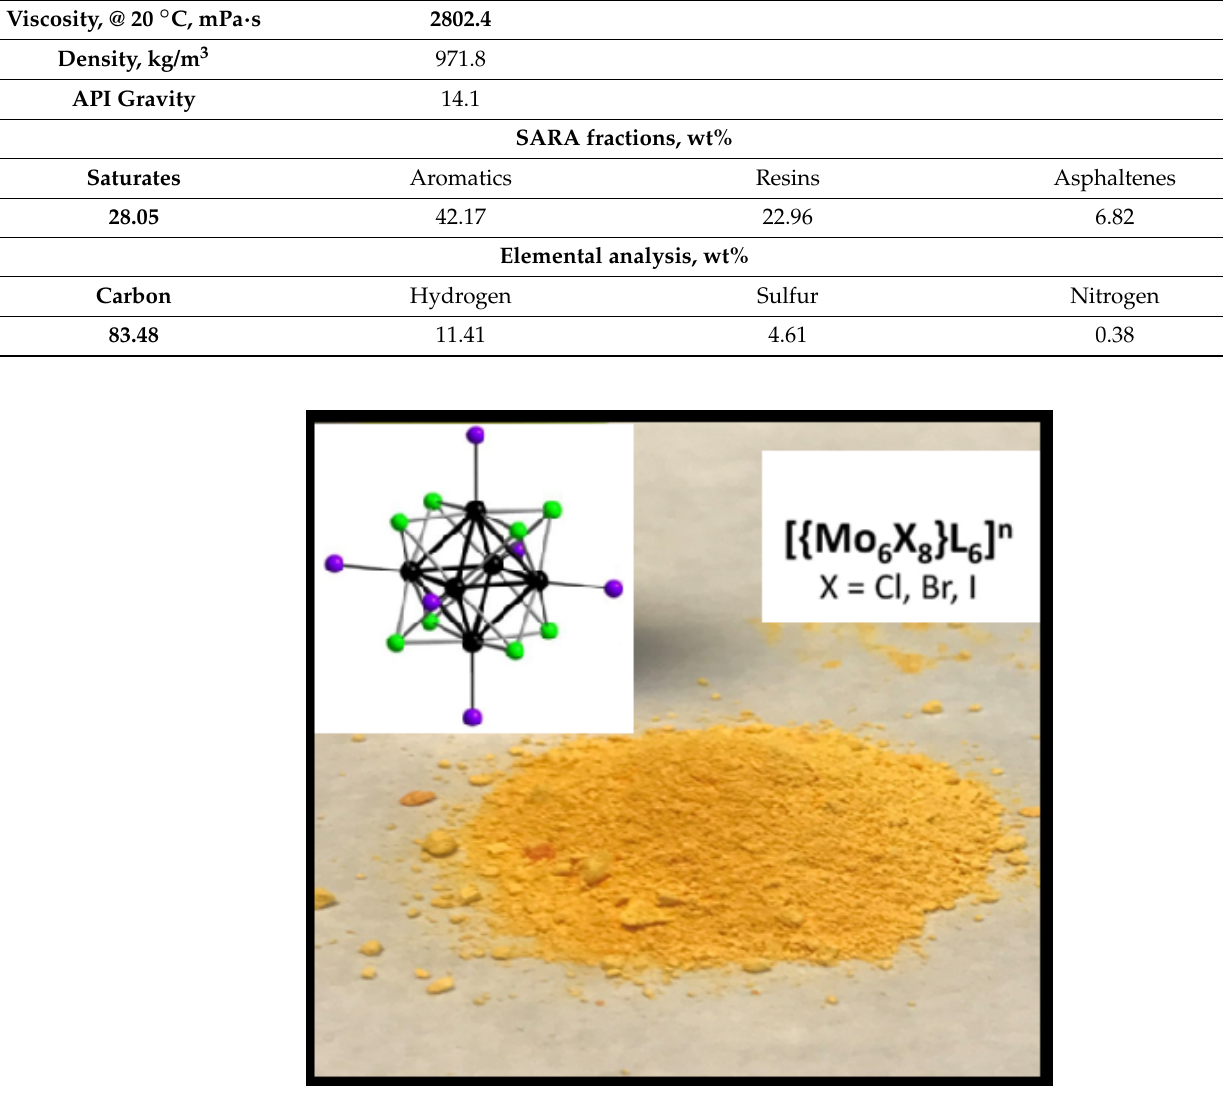
Figure 1. The obtained molybdenum octahedral cluster complexes (Mo OHCs).